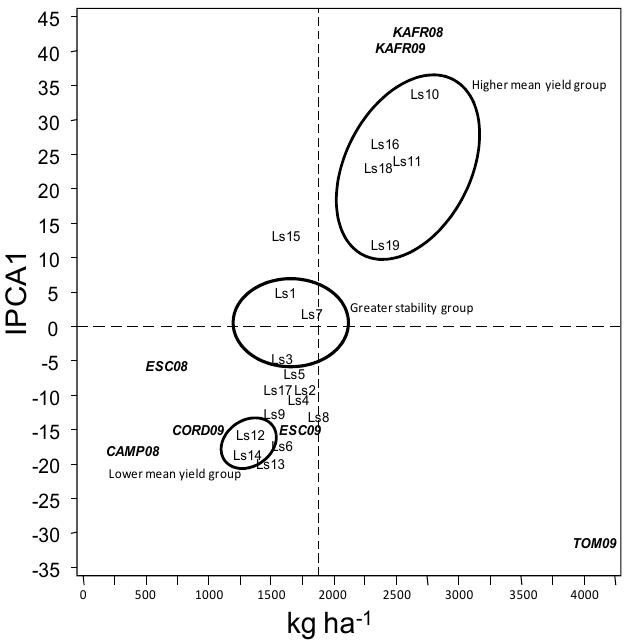
Figure 3. AMMI1 Biplot display for mean yield and IPCA 1 scores of the 19 grass pea lines tested across seven environments. Vertical line at the centre of biplot is the general grand mean.